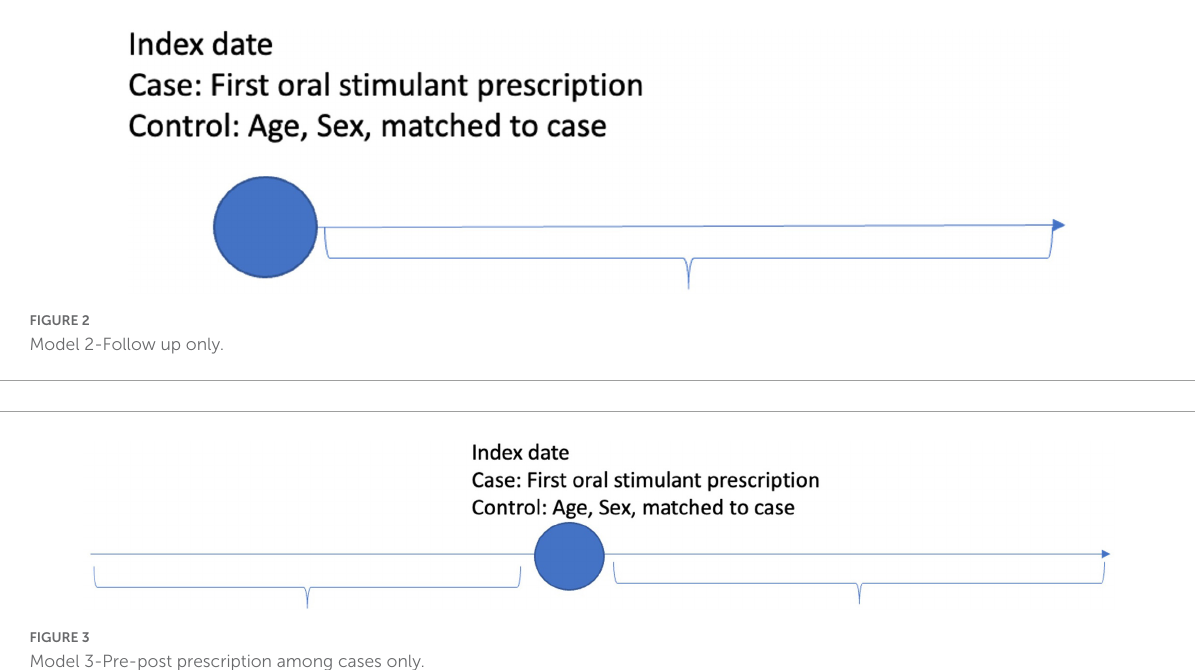
FIGURE3 Model 3-Pre-post prescription among cases